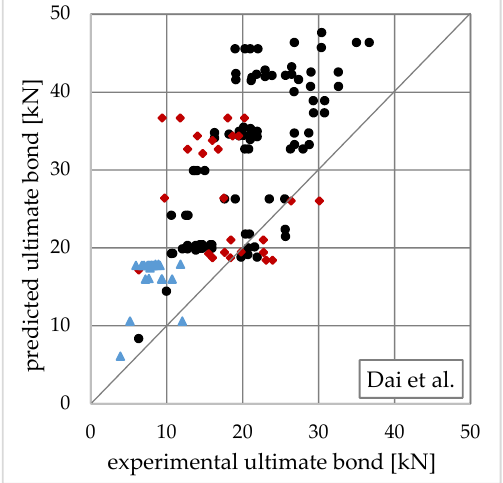
Figure 10. Test vs. predicted bond force using the Dai et al. model [22].